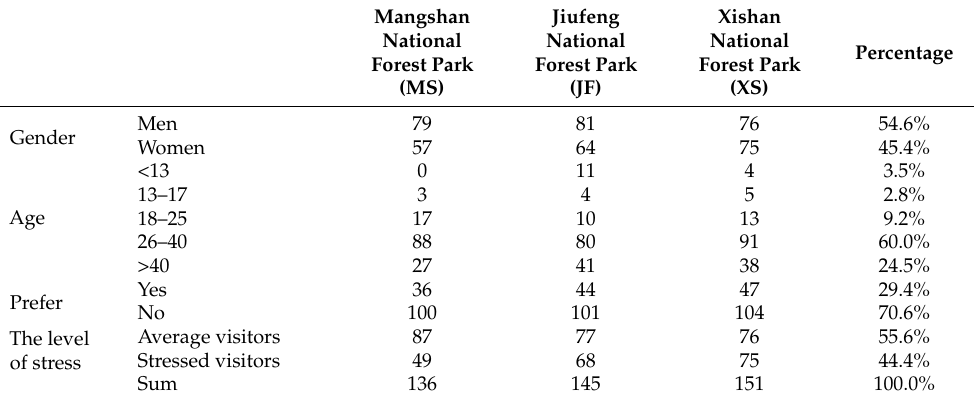
Table 4. The individual characteristics of the respondents in research